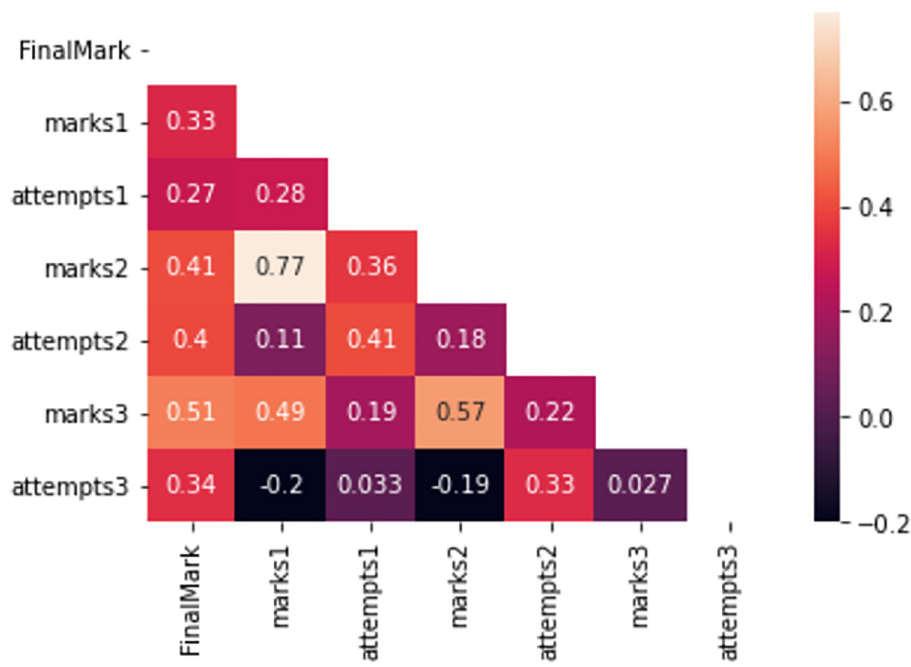
Fig 2. Correlation heatmap. Null attempts and the number of attempts are